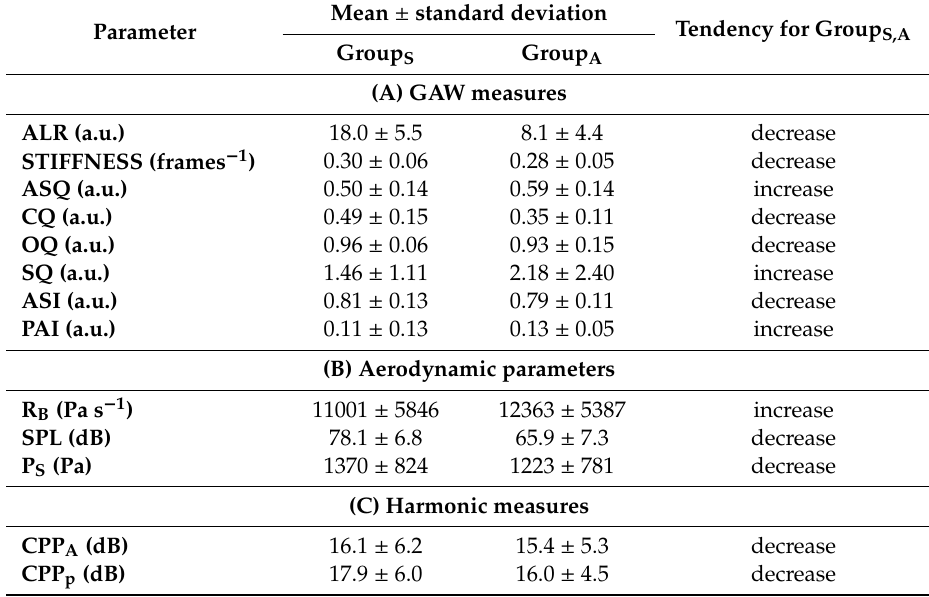
Table 6. Mean values and standard deviations for the GAW, aerodynamic and harmonic parameters of the two di ff erent vibrational characteristics with